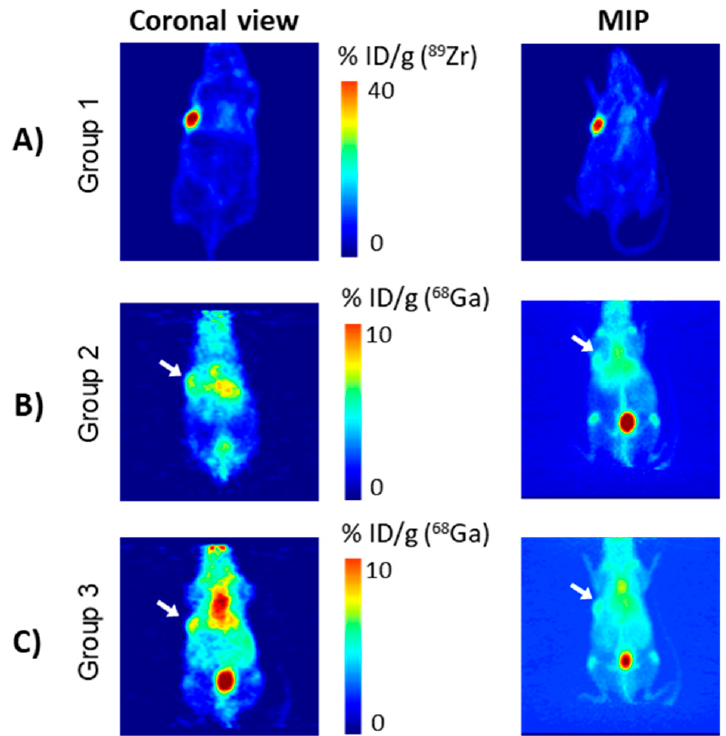
Figure 4. Representative PET images of nude mice bearing SW1222 xenografts. ( A ) Mouse treated with directly labelled 89 Zr-DFO-NCS-huA33 (25 h after injection, group 1); ( B ) mouse pretreated with THP Me -NCS-huA33 (group 2) followed at 24 h by 68 Ga acetate (imaged at 2 h 10 min after 68 Ga injection); ( C ) mouse treated with 68 Ga acetate only (2 h 30 min after 68 Ga injection, group 3). Images are reported as coronal section (left panel, thickness 0.87 mm) and MIP (right panel), voxel size is 0.87 × 0.87 × 0.80 mm 3 . White arrows indicate location of the tumour.